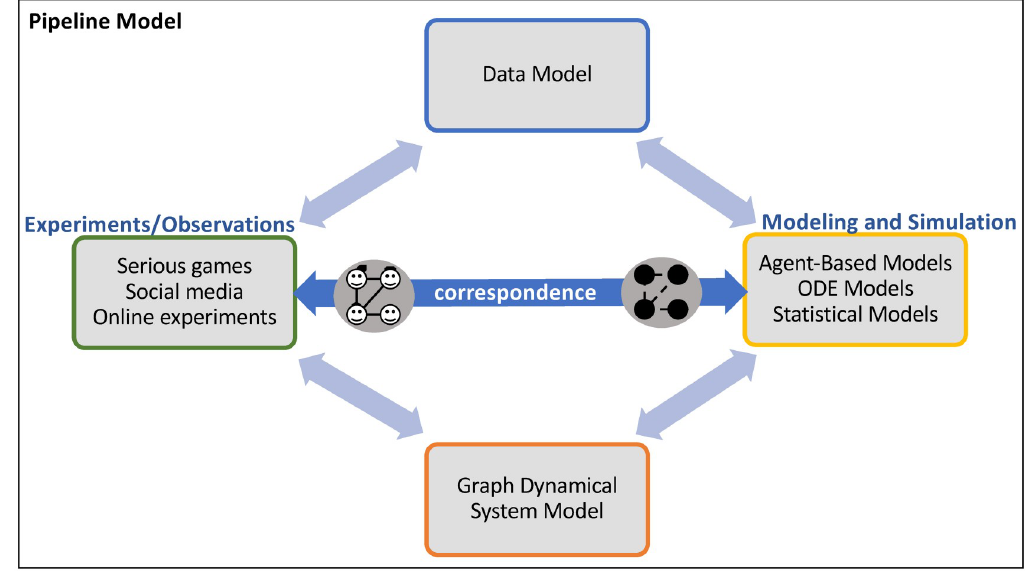
Fig 4. The three types of models described in this work: (Abstract) data model, graph dynamical system model, and pipeline model. The data model enables rigorous reasoning about both ( i ) experiments and experimental data specifications (requirements) and ( ii ) modeling and simulation (MAS) specifications. It, along with the graph dynamical system (GDS) model, help to ensure consistency and correspondence between experiments and MAS. We use GDS to model the dynamics of particular applications systems. Specific data sources and modeling approaches are shown. These are used within our pipeline model. Figure adapted from [34].